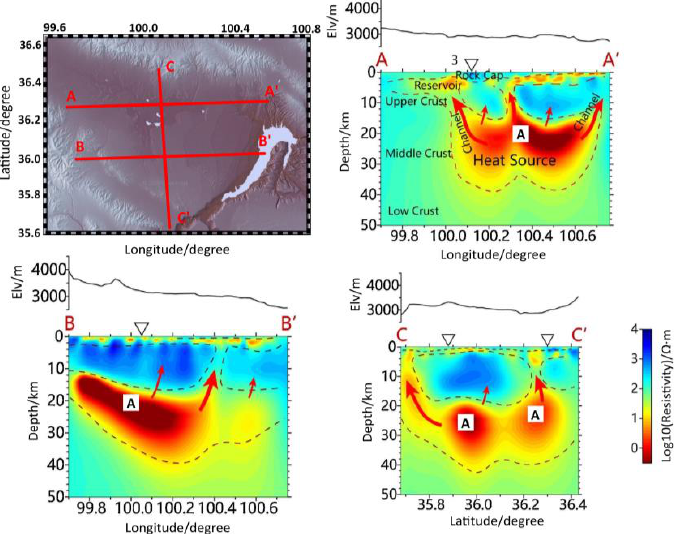
Figure 8. 3-D magnetotelluric imaging results (modified from Gao et al., 2018 [55]).